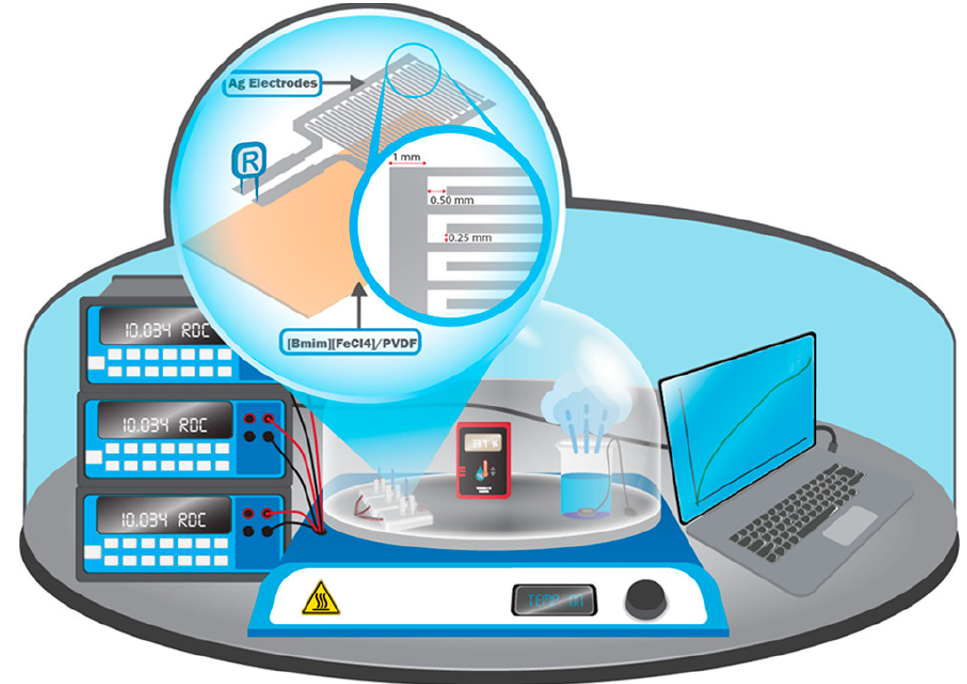
Figure 3. Schematic of the humidity sensor based on ionic liquid (poly (vinylidene fluoride)) composites. Reproduced with permission from [26].